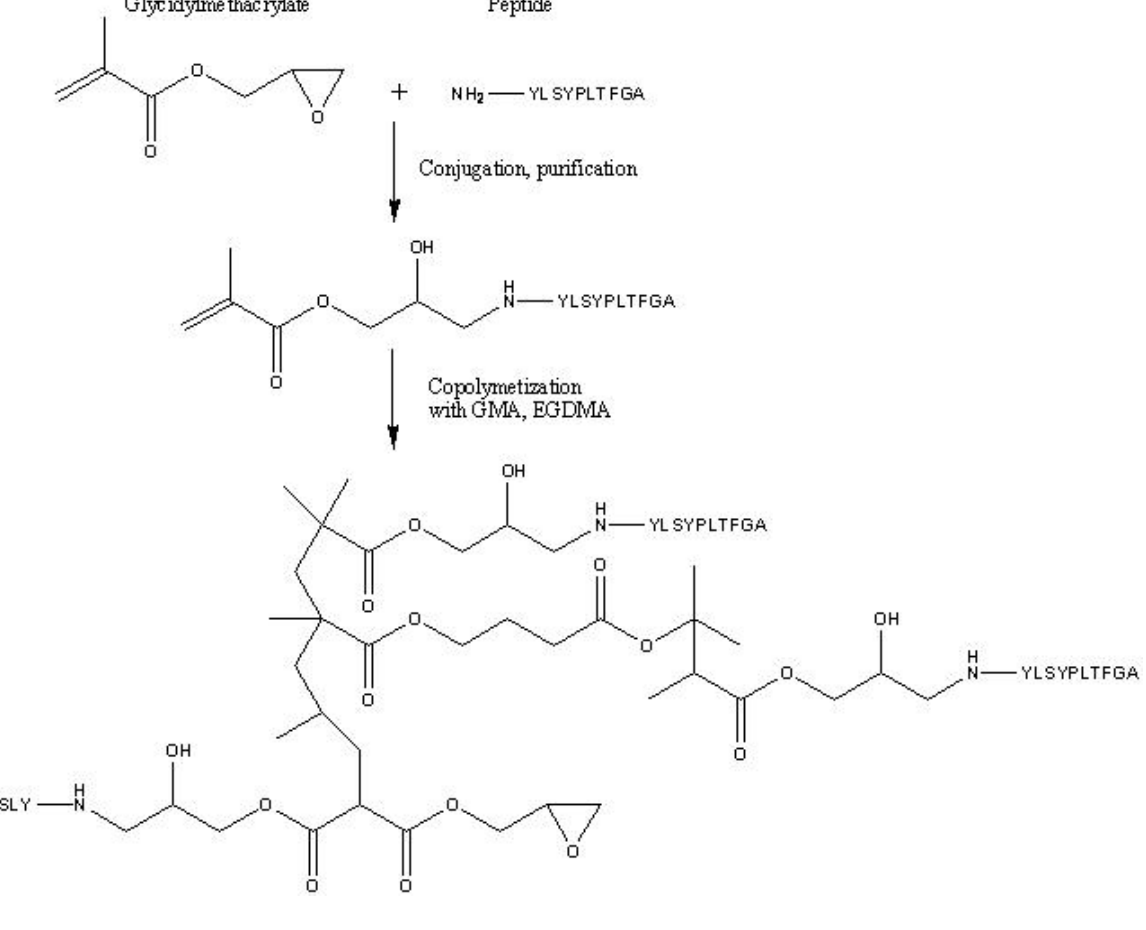
Figure 9. Schematic drawing of the preparation of an affinity monolith produced by in situ polymerization [131]. Reprinted with permission from the American Chemical